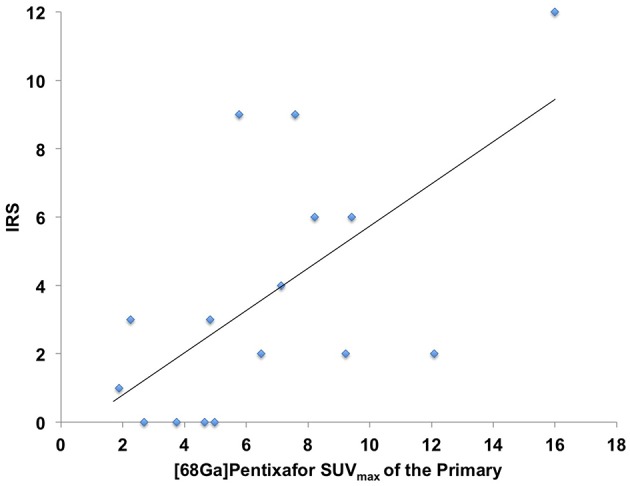
Correlation between immunoreactive score (IRS) vs. [68Ga]Pentixafor SUVmax of the primary among all tumor entities available for analysis R = 0.62.